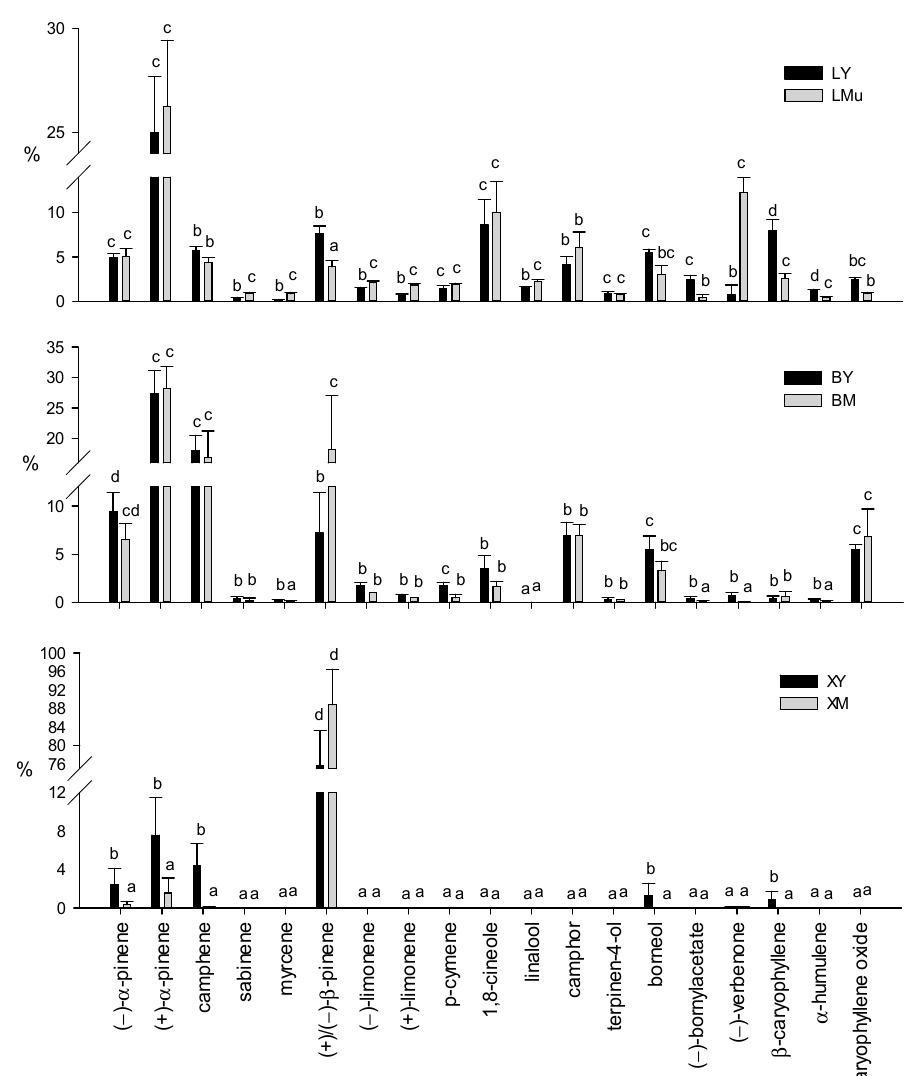
Figure 3. Relative contents of volatile terpenoids in young and mature tissues and different tissue sources from Rosmarinus officinalis L. Data are means of 9 replicates + SE (standard error). Different letters indicate significant differences (by the Mann–Whitney U-test, p < 0.05) in the relative content of each single terpene between young and mature samples of different tissue sources. L, leaf; B, cortex; X, xylem tissue; Y, young; M, mature. Samples collected from the upper part of the branch are indicated with “u”.